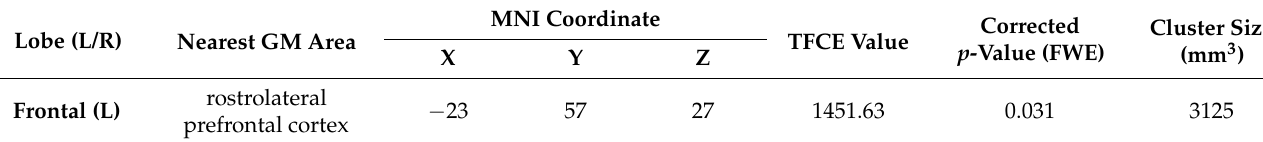
Figure 4. Associations between email addiction tendency and depression severity.